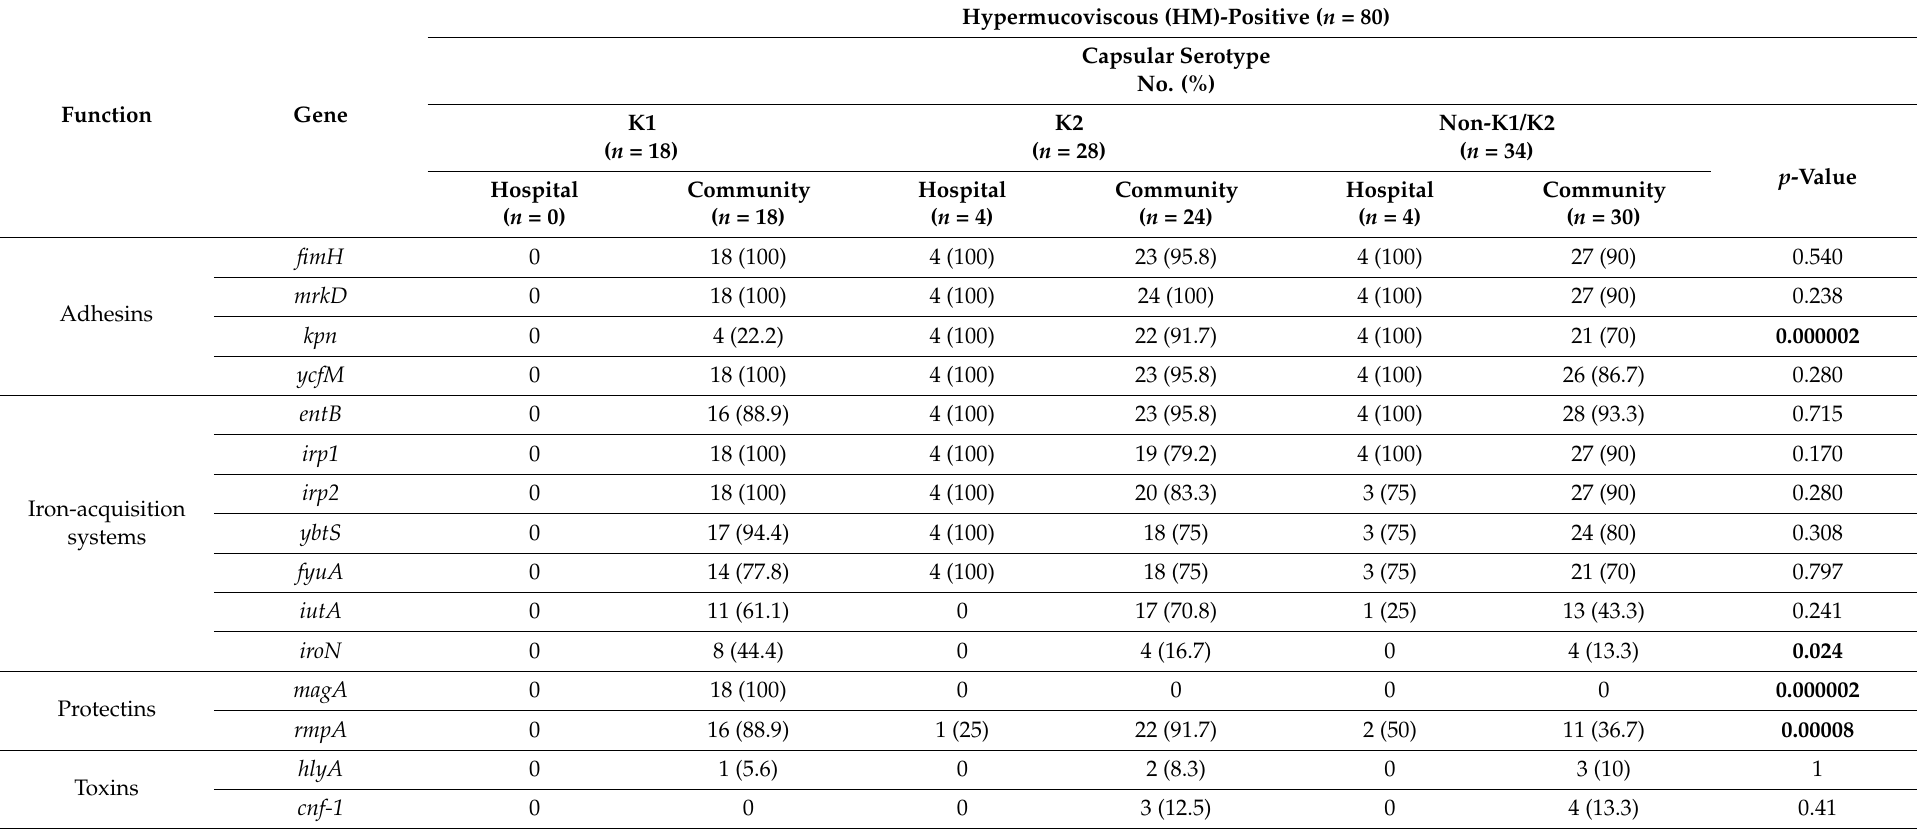
Table 6. Distribution of virulence genes according to hypermucoviscous (HM)-positive strains and capsular serotype of K. pneumoniae isolated from patients with hospital- and community-acquired